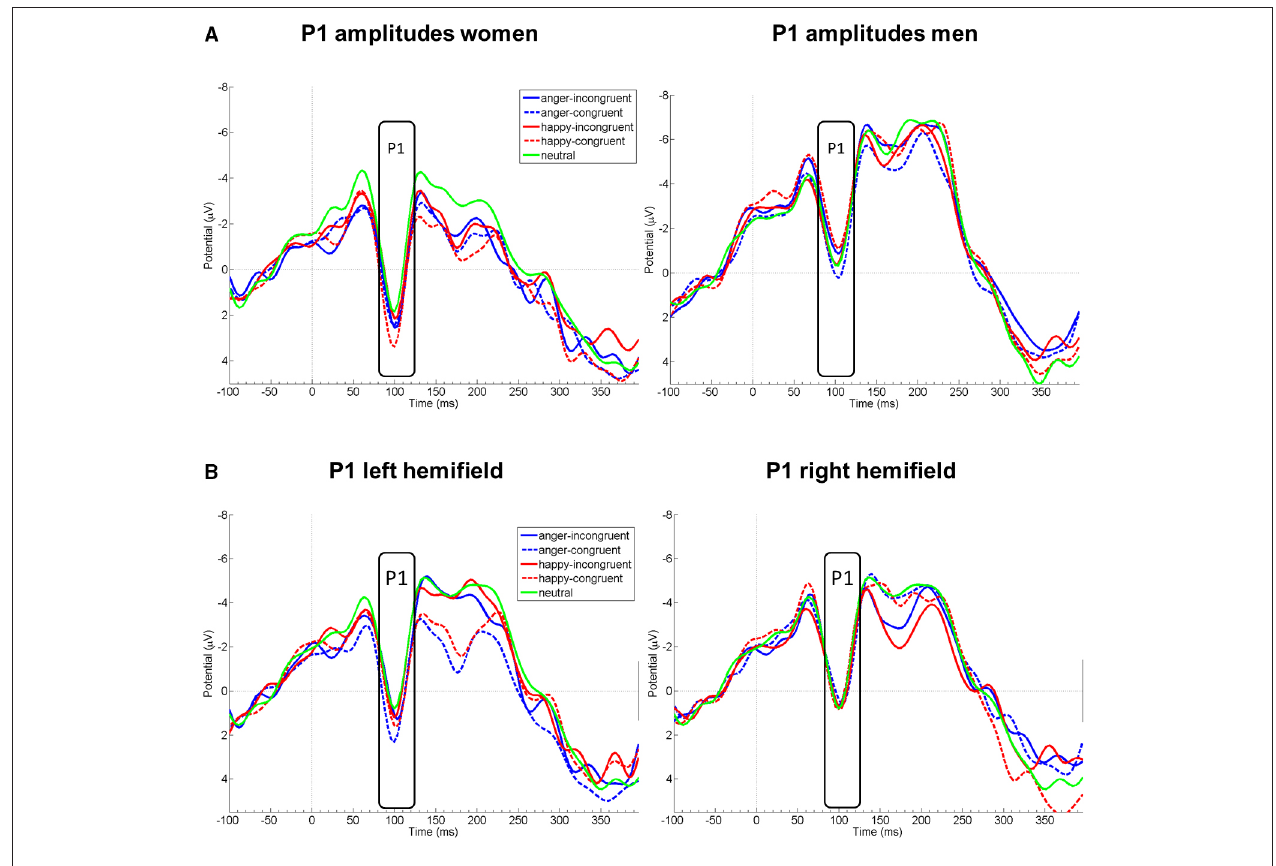
right visual hemifield. Note that the condition neutral is included in both figures of panel (B) for demonstrational purposes. Negative is drawn upward per convention. The rectangles denote probe P1 analysis time